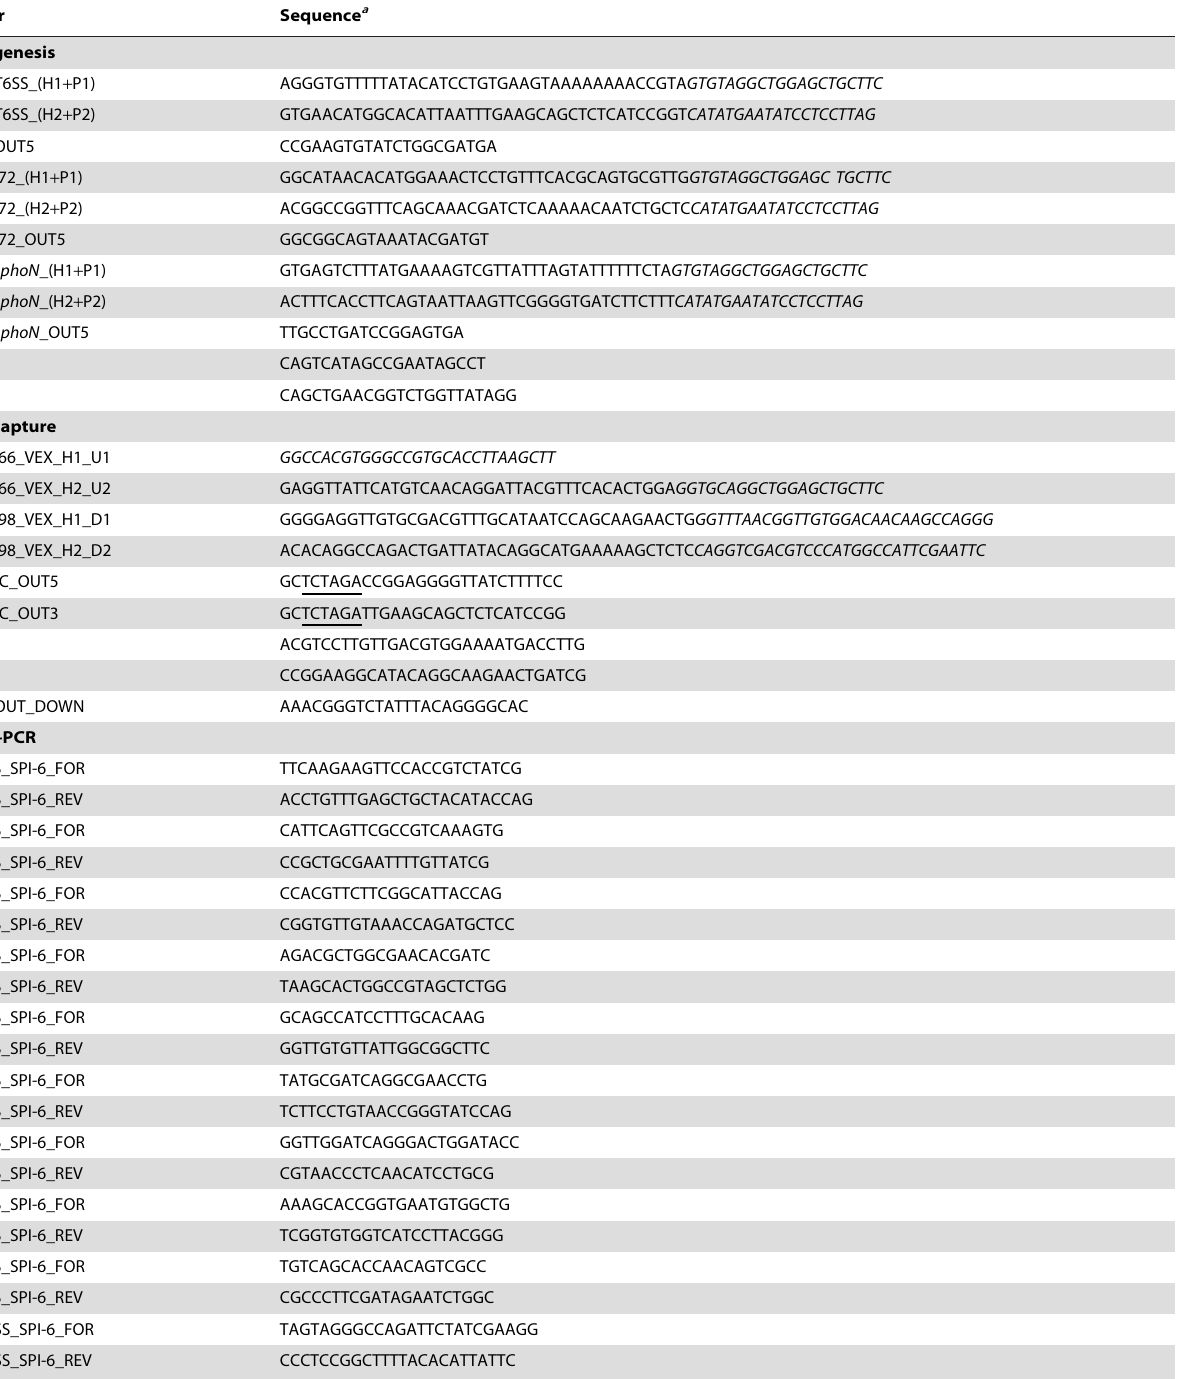
Primer Sequence